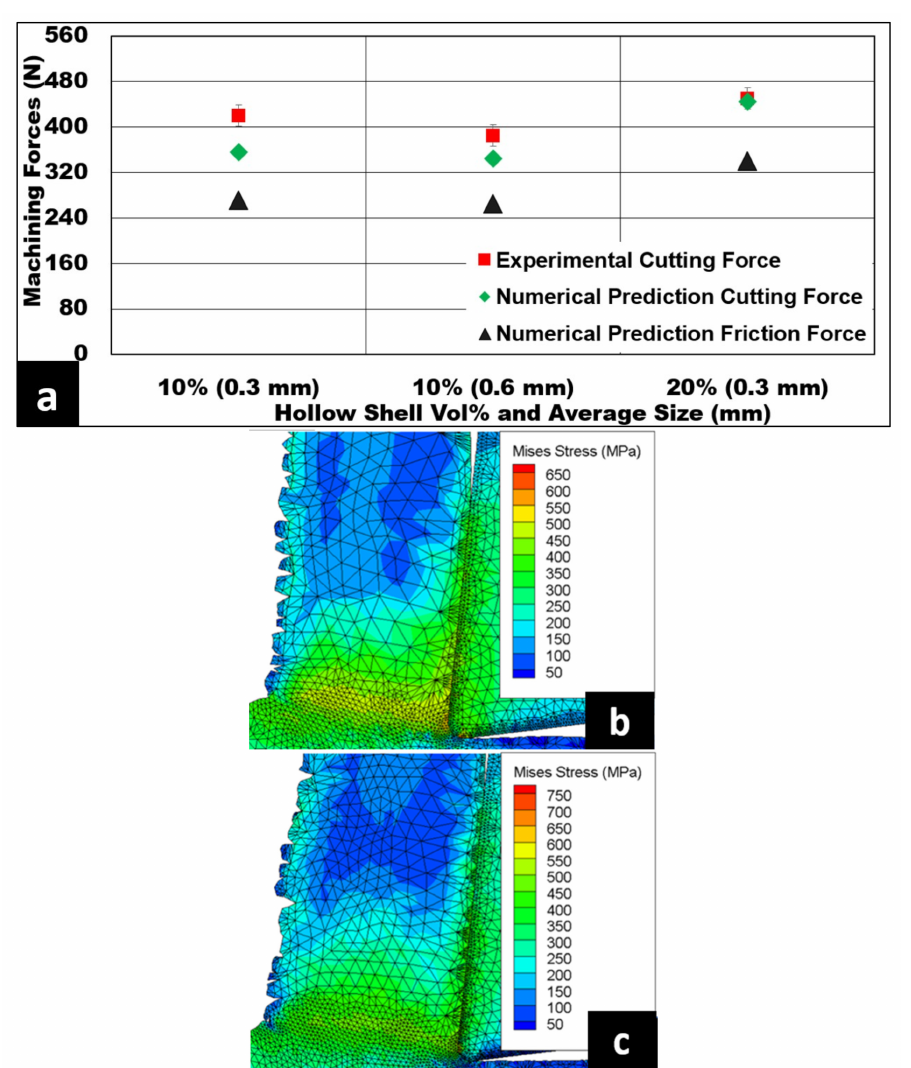
Figure 7. ( a ) Effect of reinforcement volume percentage on machining force (AdvantEdge TM simula- tion); 6061/hollow alumina shell syntactic foams (Vc = 50 m/min, h = 0.07 mm); Von Mises stress contour ( b ) 10% hollow alumina and ( c ) 20% hollow